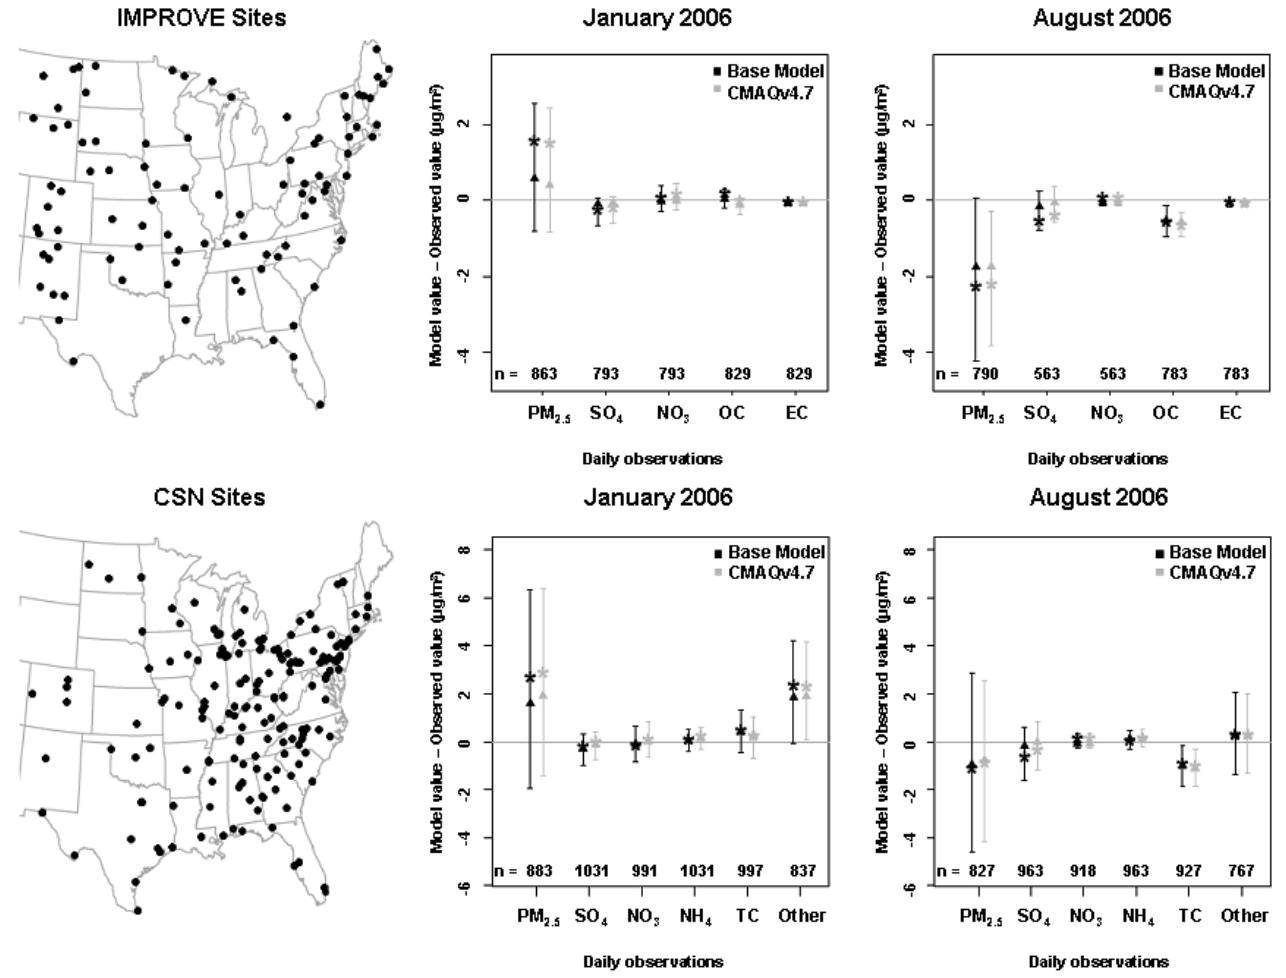
Fig. 10. Mean (star), median (triangle), and inter-quartile ranges of model bias (model value – observed value) for multiple fine-particle species measured at IMPROVE and CSN sites in the 12km domain. IMPROVE and CSN observations are daily averages. The number of model/observation pairs for each species is shown above the x-axis.